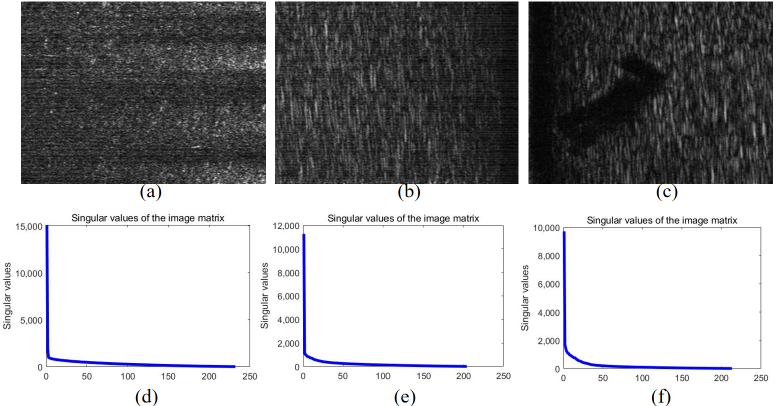
Figure 4. Sonar background images and their singular value results. The first row ( a – c ) shows three sonar background images and the second row ( d – f ) shows the singular values of the corresponding preprocessed images. ( a – c ) The background images with a different submarine environment, and the black area is an acoustic shadow in subfigure ( c